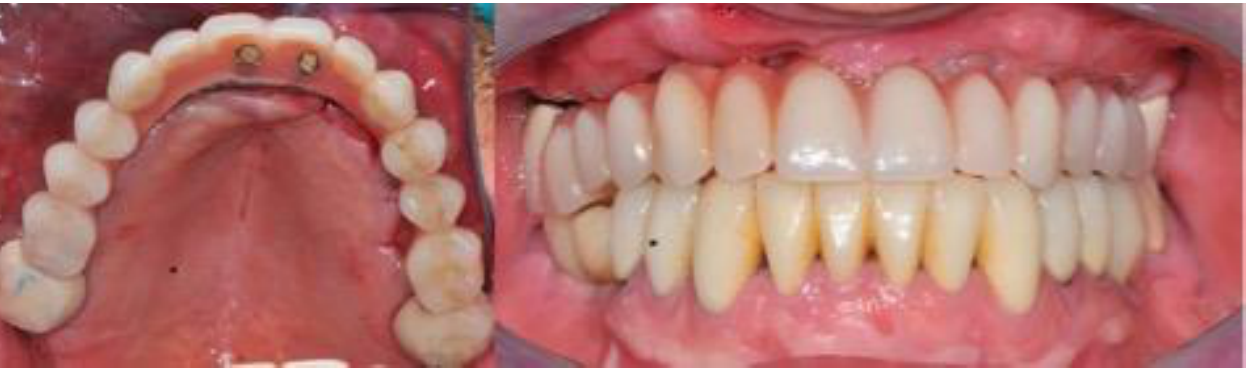
Figure 3. Occlusal and frontal intra-oral aspects of the immediate loaded full arch prosthesis. Left: occlusal view. Right: front view.